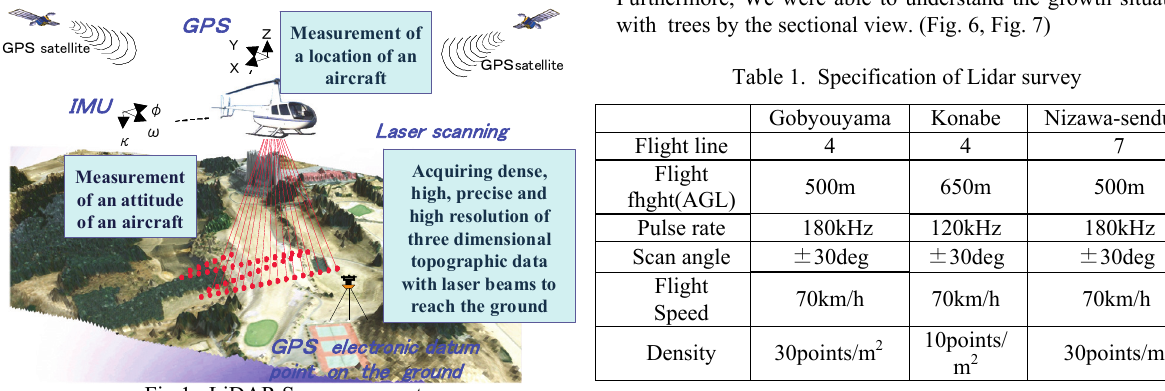
Fig 1. LiDAR Survey concept 3. RED RERIEF IMAGE MAP On Red Relief Image Map, as slopes became steeper, they become redder, and ridges are whiter compared to the darker black valleys. Red Relief Image Map is a pseudo color image. It is result of synthesizing mathermathically converted images through various topographic filtering. This is a complementely unique technique of relief visualization that is significantly